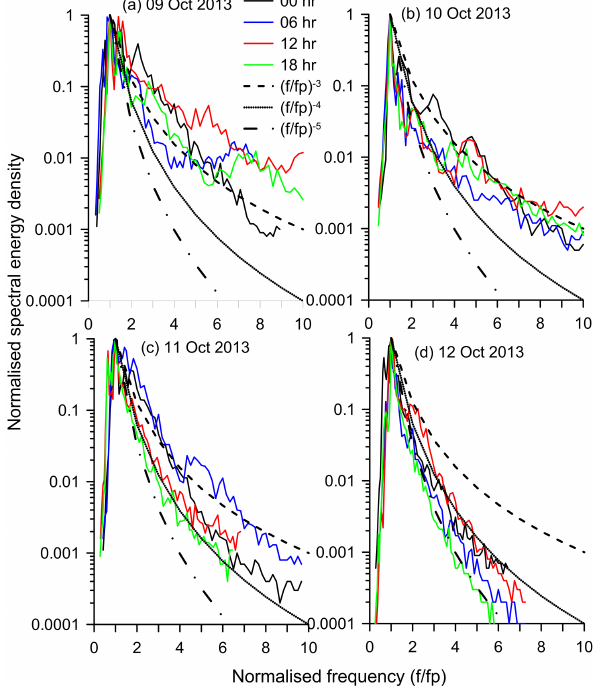
Figure 14. The normalised wave spectra during 9–12 October at different times. The slope of the high-frequency part of the spectra before the cyclone is f − 3 and during the cyclone it is between f − 4 and f − 5 .